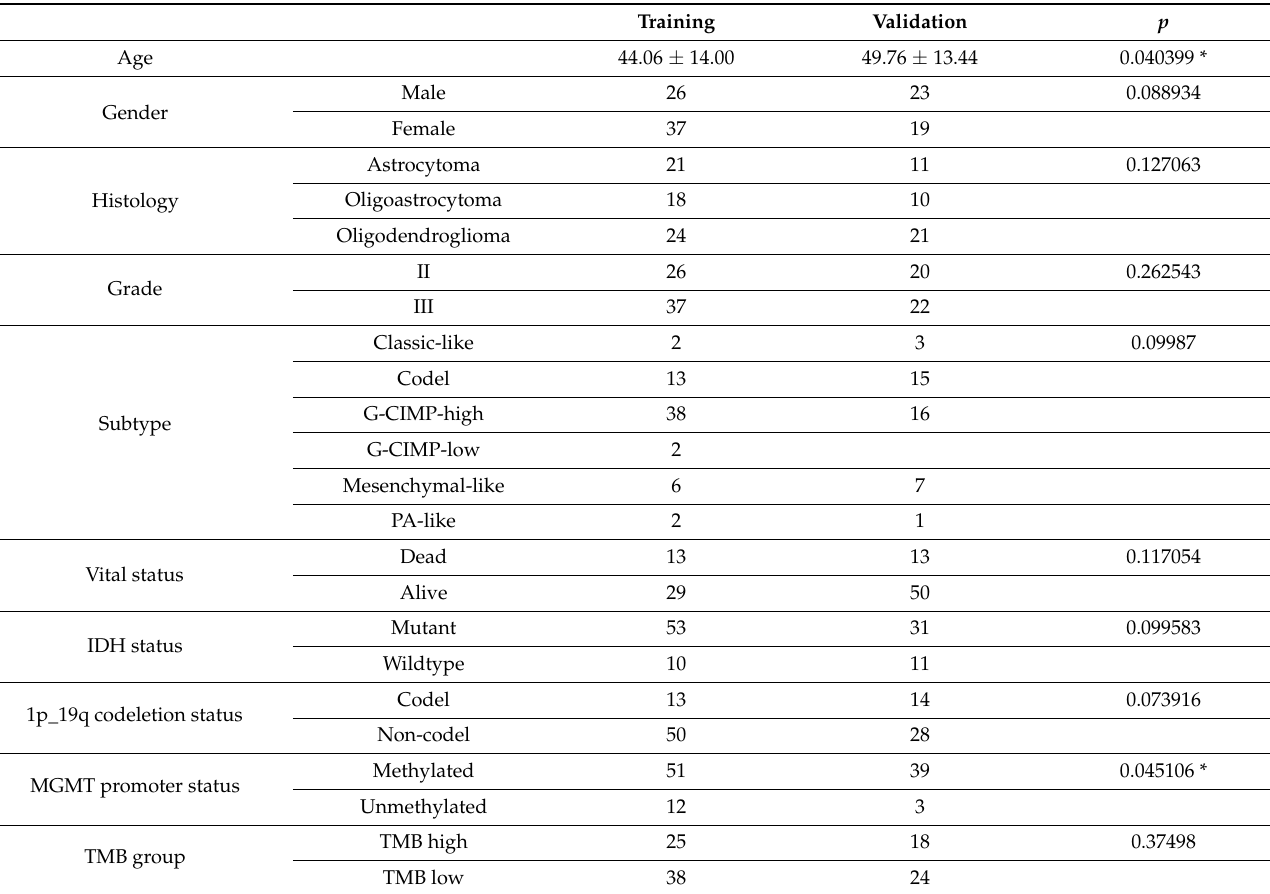
Table 1. Patient characteristics.